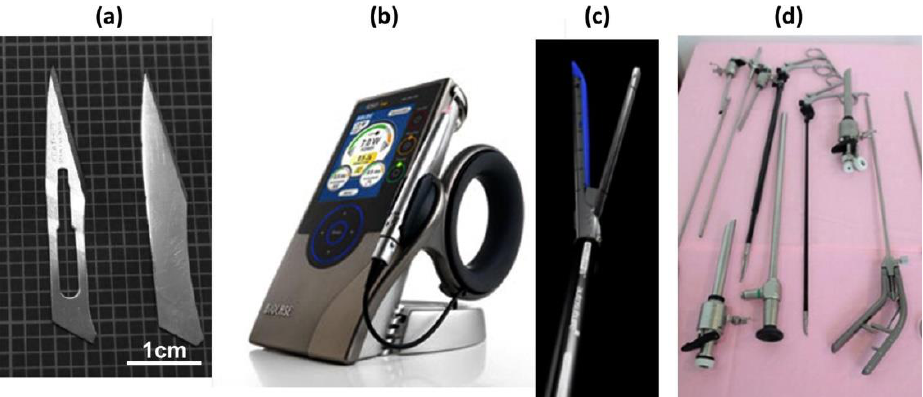
Figure 17. Ashby diagram comparing the mechanical properties of conventional bioglasses, biometals and the novel biomedical BMGs [224]. Reprinted with permission from Elsevier.